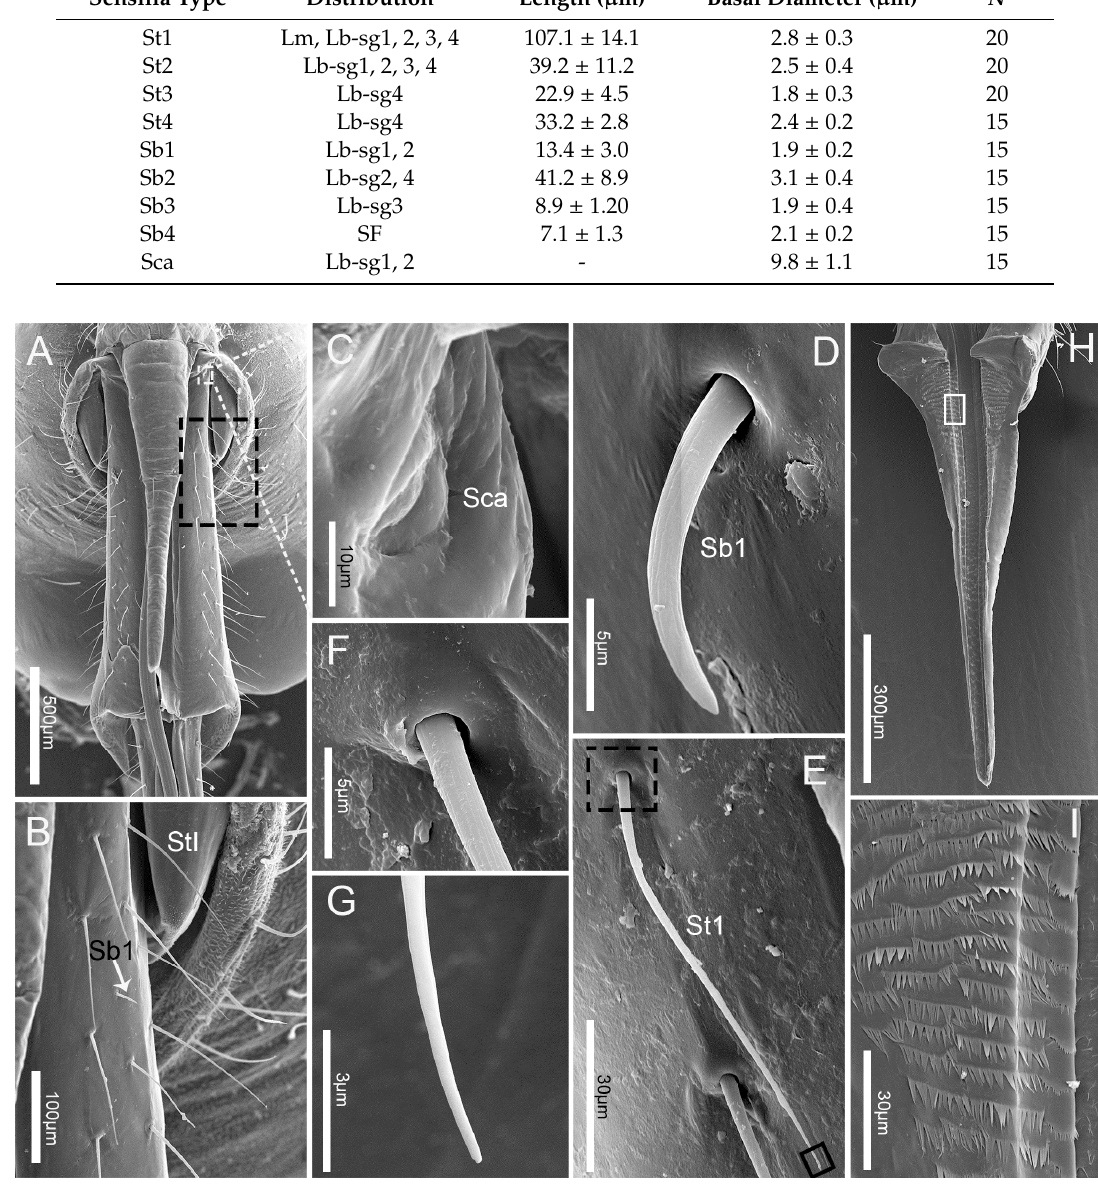
Figure 3. SEM of first labial segment and labrum of C.nigrescens . ( A ) Dorsal view of the first labial segment and labrum; ( B ) enlarged view of outlined box in ( A ), showing sensilla trichodea I (St1) and sensilla basiconica I (Sb1); ( C ) enlarged view of sensillum campaniformium (Sca); ( D ) sensillum basiconicum I (Sb1); ( E ) sensillum trichodeum I (St1); ( F ), ( G ) enlarged view of outlined box in ( E ), showing the base and tip of sensillum trichodeum I (St1), respectively; ( H ) epipharynx; ( I ) enlarged view of epipharynx; St 1, sensilla trichodea I; Sca, sensilla campaniformia; Sb1, sensilla basiconica I.